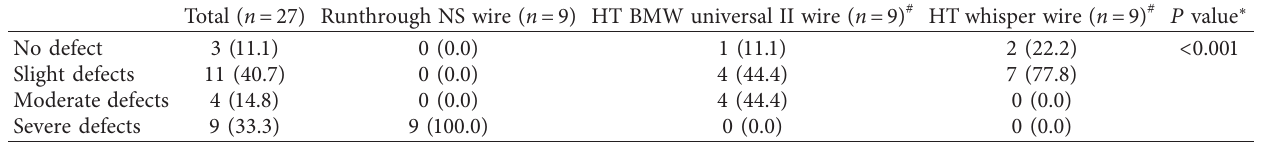
Figure 2: Representative SEM images of stent coating integrity after the procedure of JWT from the Runthrough NS wire group (a), HT BMW Universal II wire group (b), and HT Whisper wire group Table 2: Impact of the three types of wire on coating integrity in the procedure of JWT.